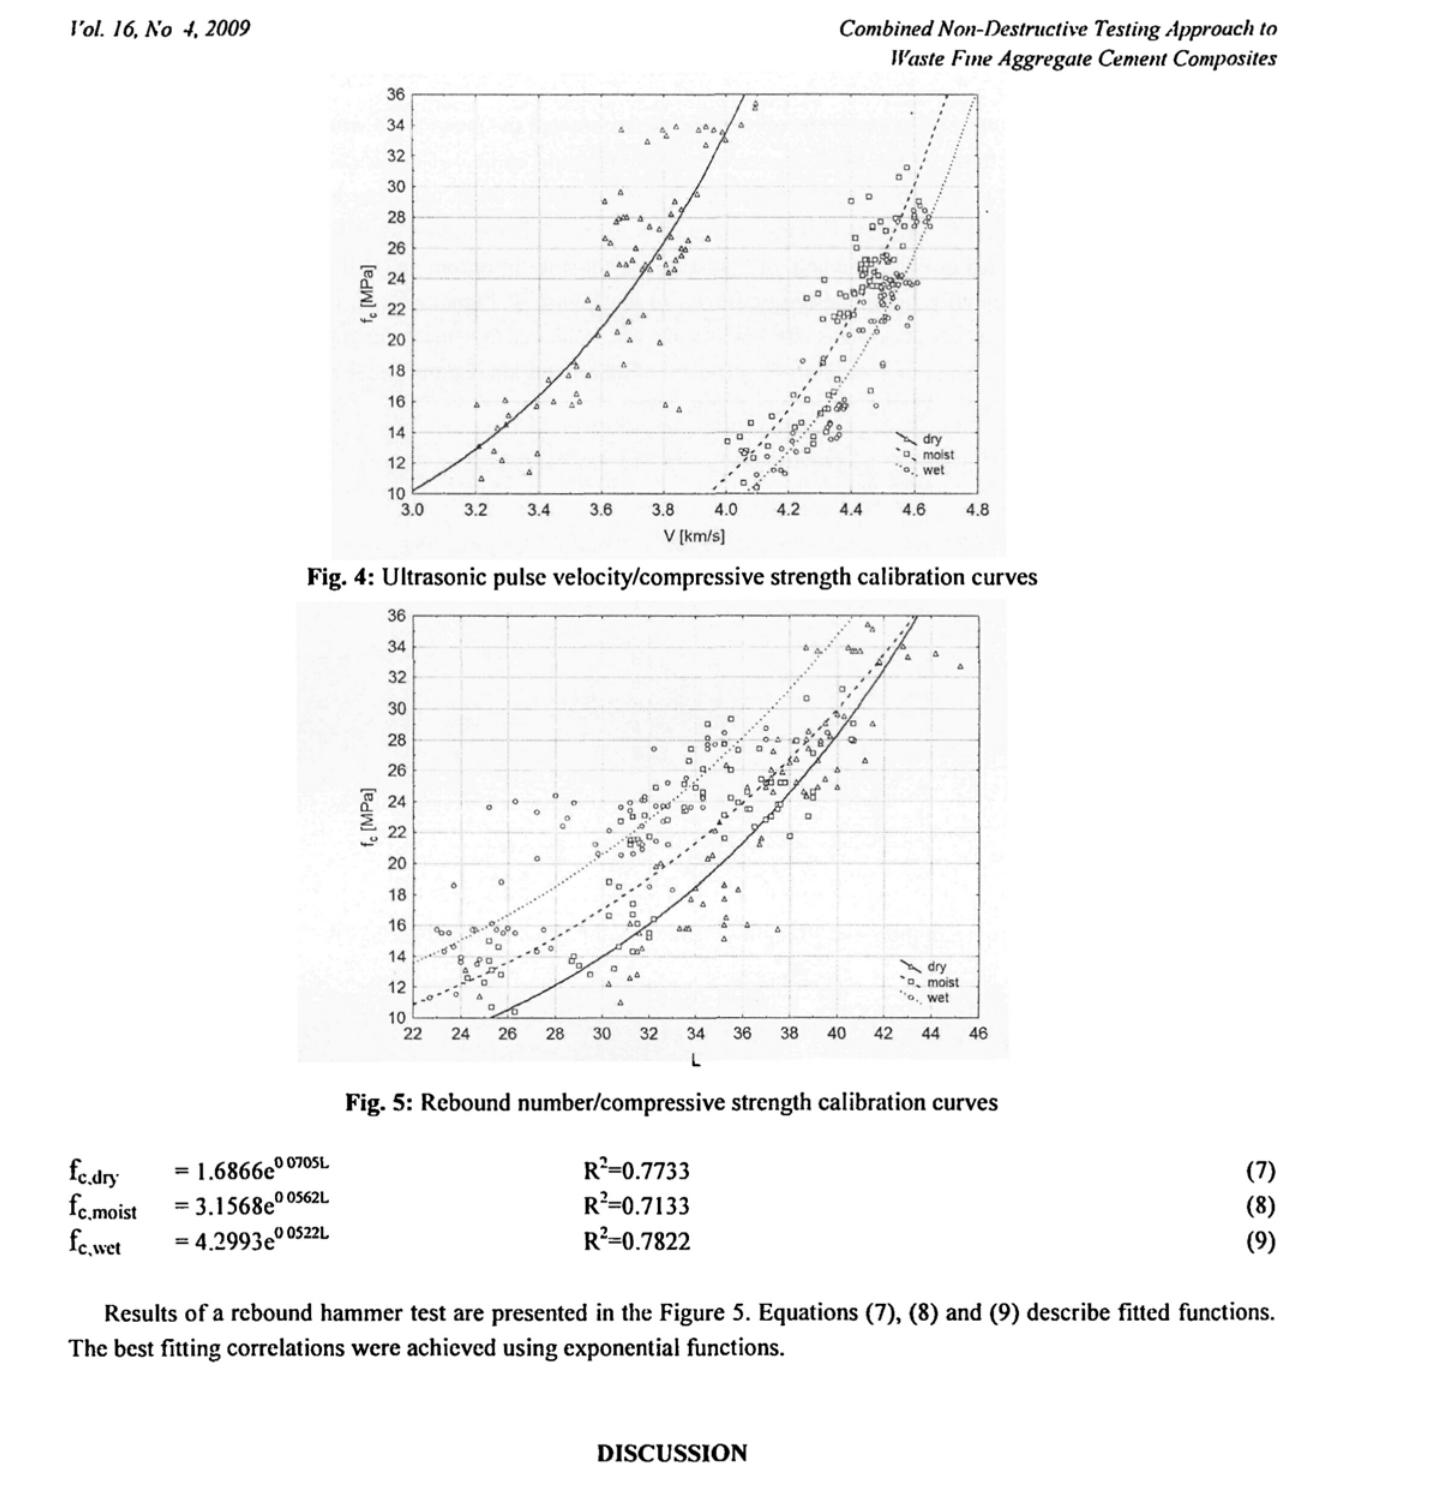
Fig. 5: Rebound number/compressive strength calibration